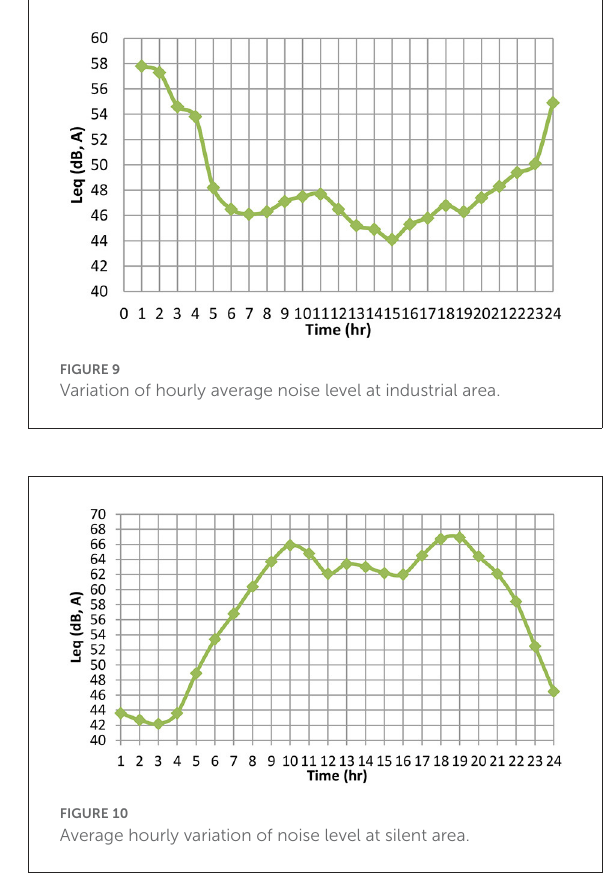
FIGURE7 Variation of hourly average noise level at Ashram Chowk.